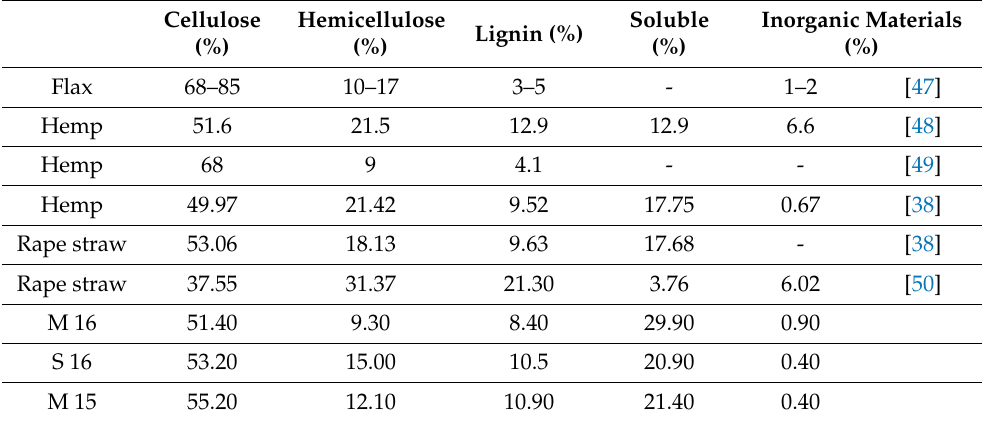
Table 2. Chemical compositions of different aggregate sizes reported in the literature and rapeseed straws